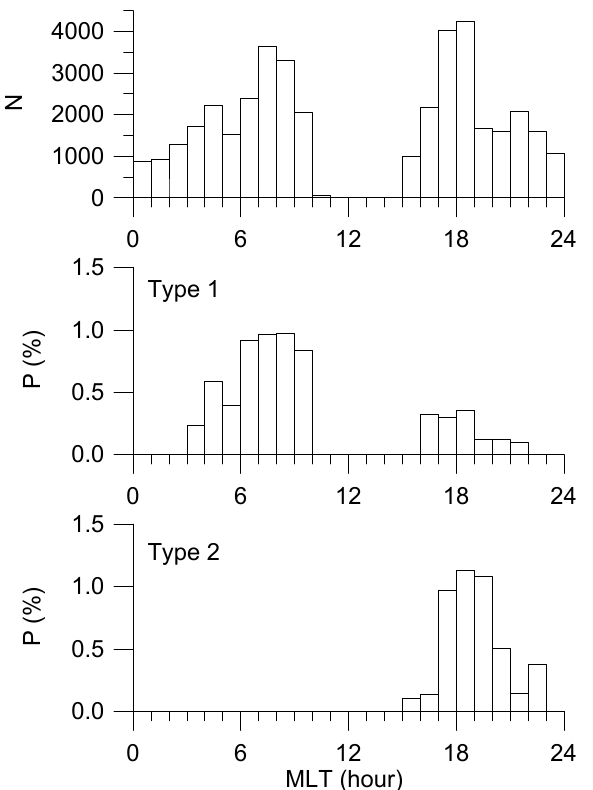
Fig. 2. Observational statistics for localized proton precipitations as a function of MLT. Upper panel: number of NOAA-12 passes in 1-h MLT intervals for 1996. Middle panel: Occurrence rate of the Type 1 events. Bottom panel: Occurrence rate for the Type 2